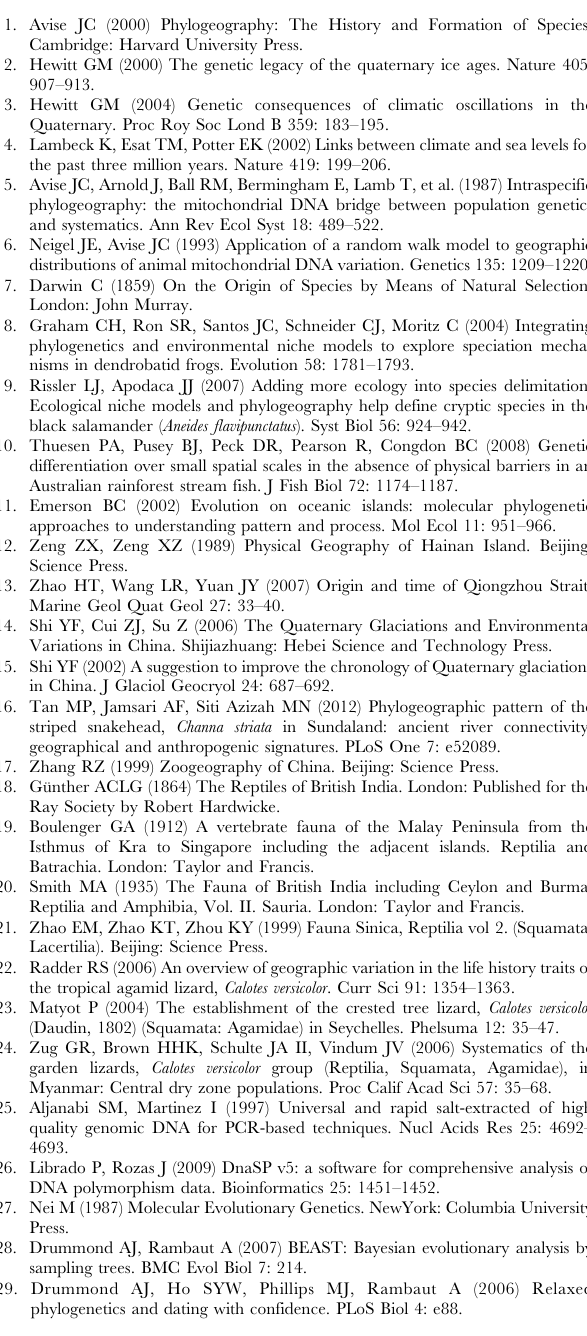
Table S1 Accession numbers for the outgroup sequenc- es retrieved from GenBank and used for phylogenetic analyses of Fiure S1. Table S2 Results of the principal components analysis of 19 bioclimatic